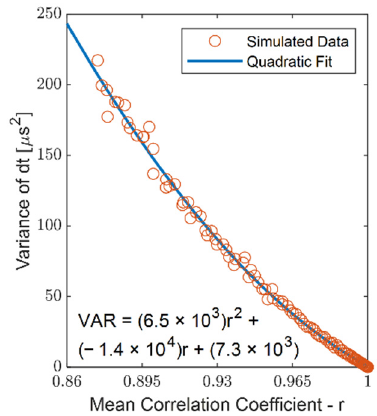
Figure 5. The variance of dt ( ∆ T or τ in application) with respect to the mean correlation coefficient r is well-approximated with a quadratic fit.